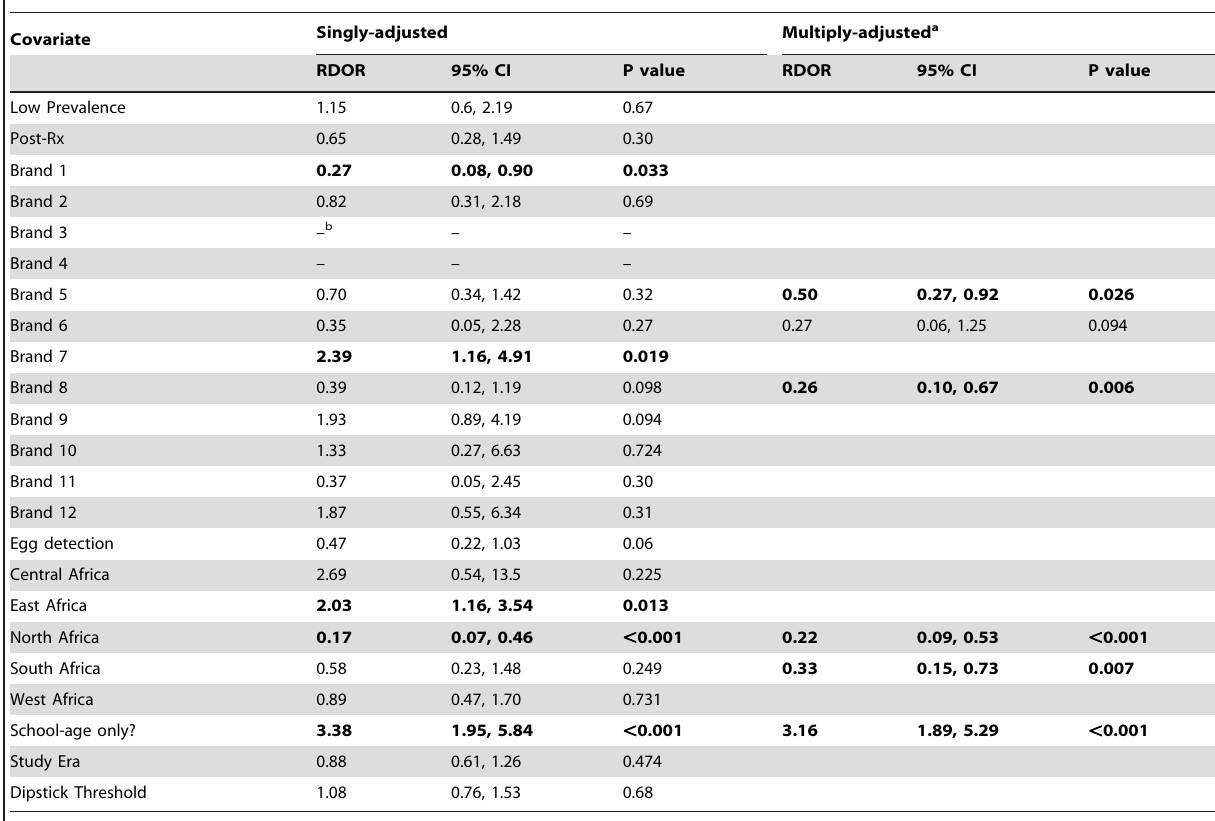
Table 3. Exploration for sources of heterogeneity.